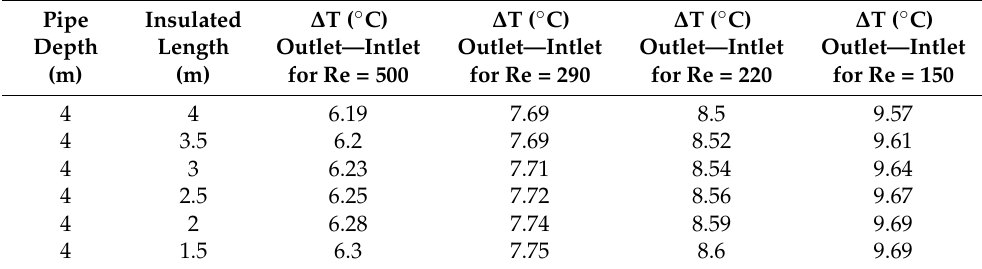
Table 16. Results of the heating potential according to the isolated length of the GAHE outlet pipe.